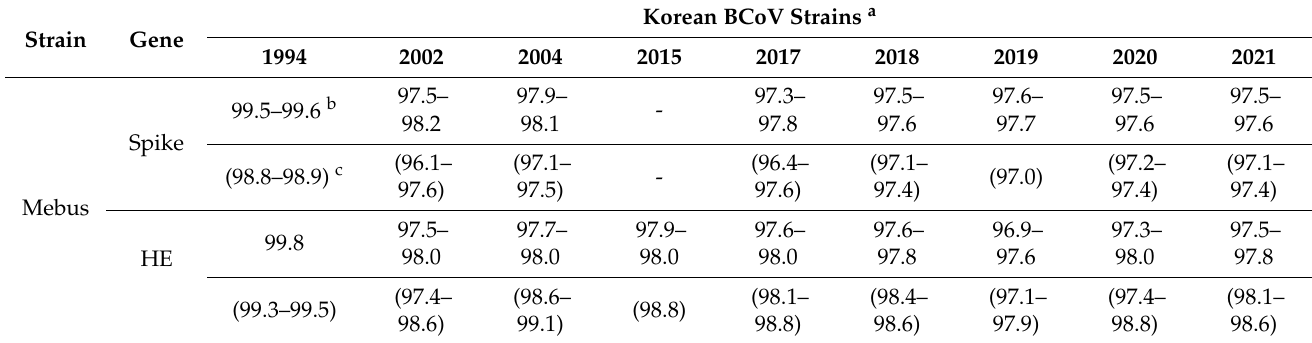
Table 1. Comparison of the nucleotide and deduced amino acid sequences of the BCoV spike and hemagglutinin esterase genes according to year.